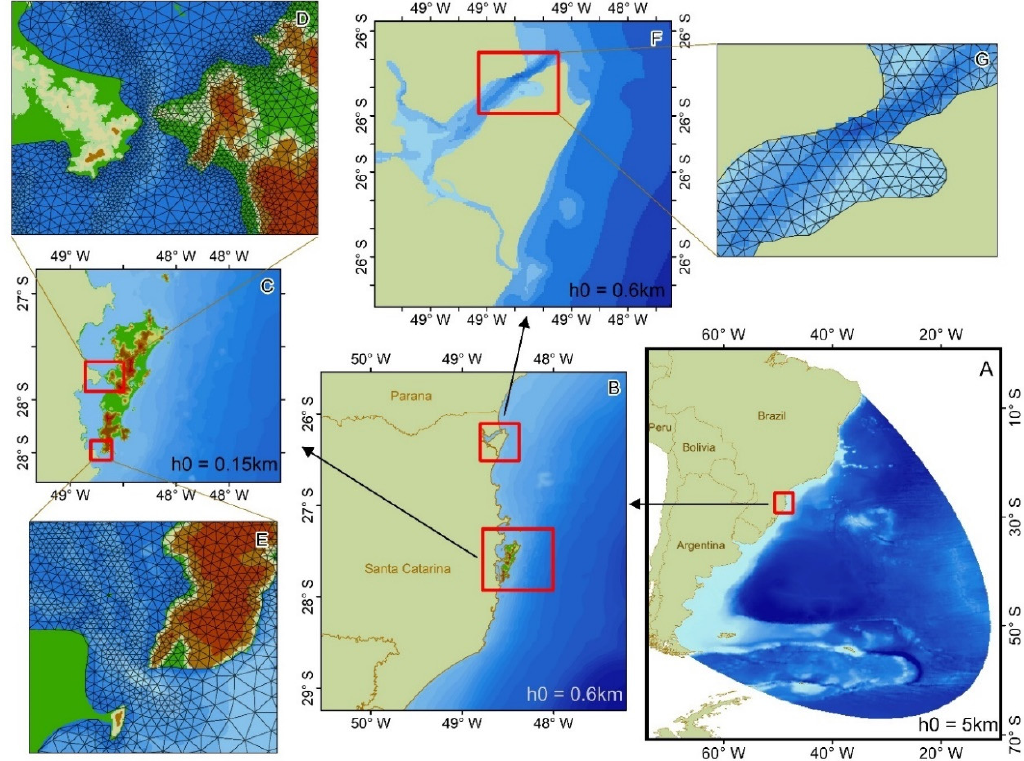
di ff erent resolutions used in the unstructured numerical Figure 3. ( A ) Numerical modeling domain; ( B ) Santa Catarina State coastal areas; ( C – G ) Detail of the different resolutions used in the unstructured numerical mesh.